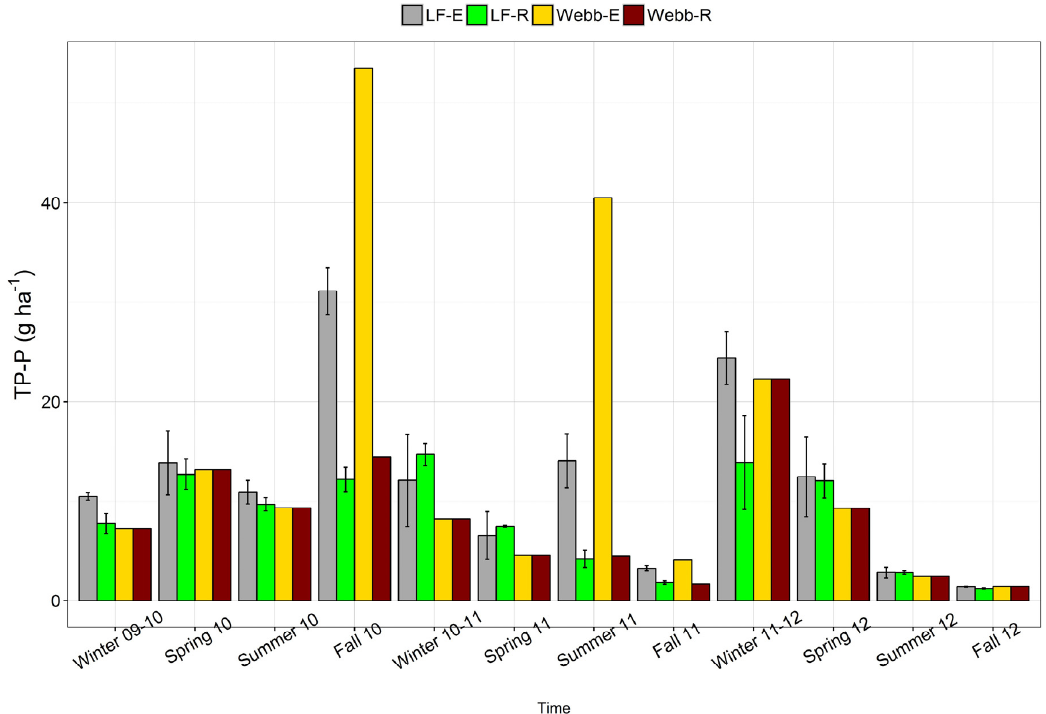
Figure 3. Predicted seasonal TP-P export fluxes for the different load calculation method groups; the error bars indicate the differences between the three best load calculation models based on the validation. For Webb-E and Webb-R, no validation was possible (due to the method).